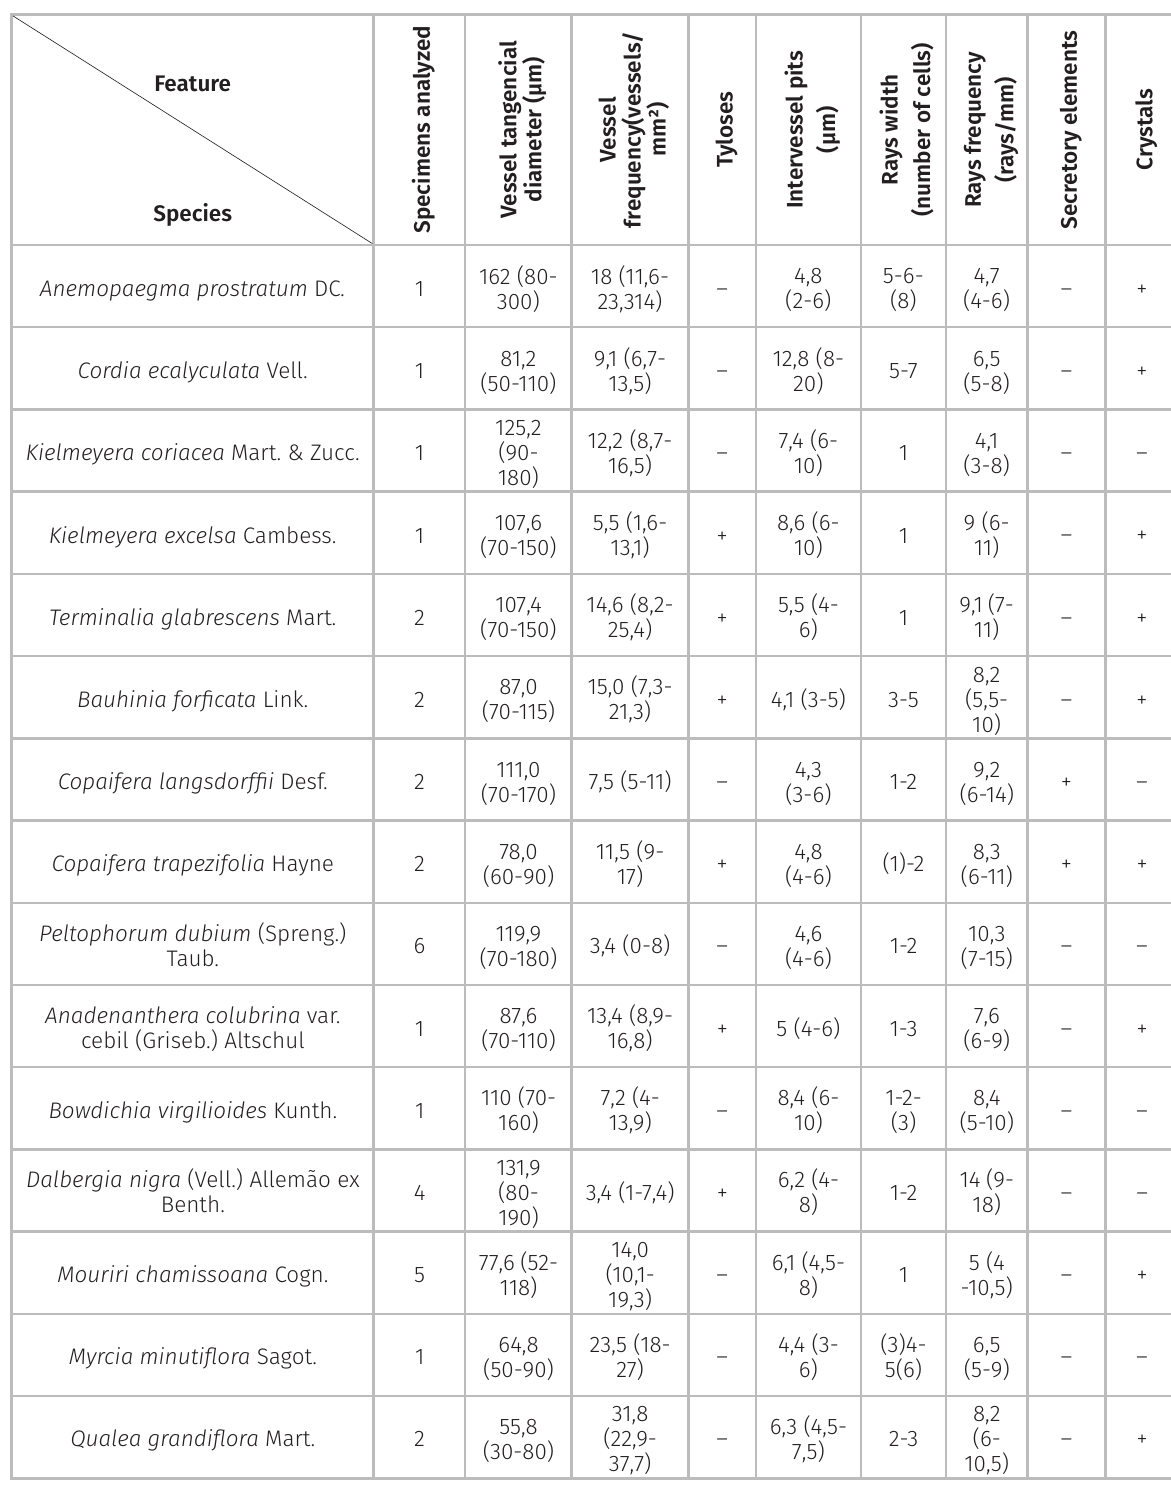
Table II. Synthesis of main qualitative and quantitative data for wood anatomical features of the studied species and number of individuals analyzed. (+)= present; (-)= absent